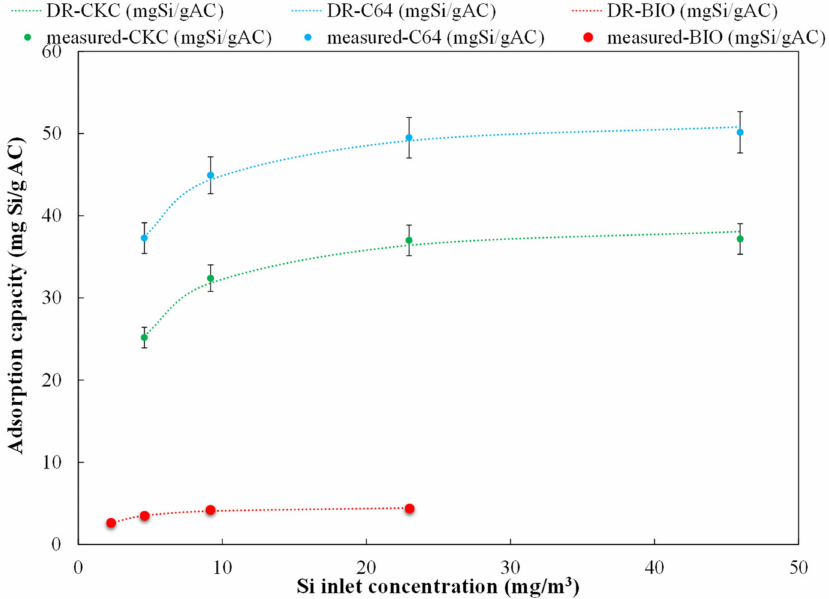
Figure 5. Dubinin–Radushkevich isotherm for D4 removal with biochar, C64 and